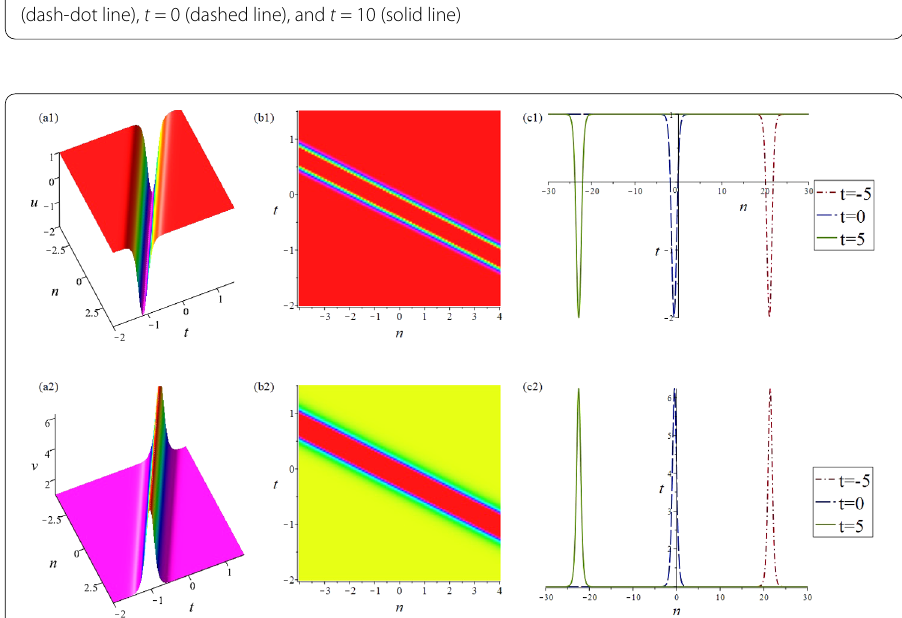
Figure 1 ( a1 ), ( b1 ) Overtaking elastic interactions of dark two-soliton solution (cid:8) u n in (43) with the parameters r 1 = –1, r 2 = 1, λ 1 = –2, λ 2 = –4. ( a2 ), ( b2 ) Overtaking elastic interactions of bright two-soliton solution (cid:8) v n in (43) with the same parameters as in (a1), (b1). The interaction processes for ( c1 ) (cid:8) u n and ( c2 ) (cid:8) v n at t = –10 (dash-dot line), t = 0 (dashed line), and t = 10 (solid line)